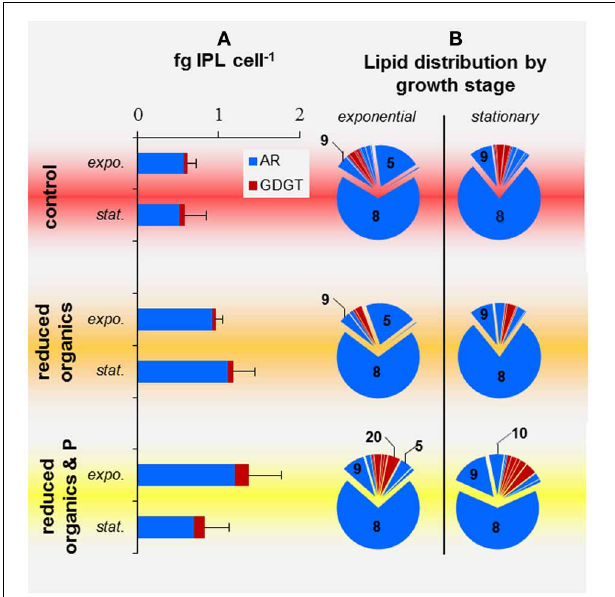
FIGURE 6 | IPL profiles of T. kodakarensis harvested at exponential or stationary phases from various media. (A) Cell quotas of AR (blue) and GDGT (red) IPLs; error bars represent standard deviation. (B) Relative abundance of IPLS; those that composed > 5% are noted by the respective IPL number provided in Table 2 .